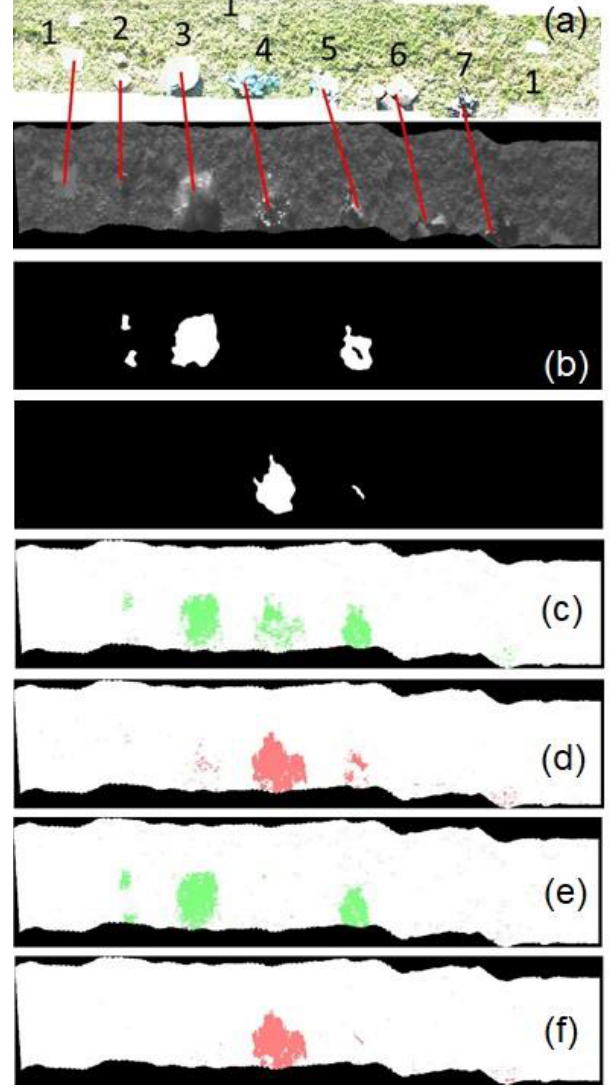
Figure 8. ( a ) Identification of materials. Panel above is a mosaic of visible-spectrum images, below the corresponding hyperspectral cube layer for wavelength 1010 nm; (1) white floor tiles; (2) LDPE wrapping bags; (3) LDPE wrapping sheet; (4) PET bottles (5) HDPE bottles; (6) wood; (7) glass bottles. Background is low grass. ( b ) Manually drawn masks for PE (above) and PET (below): Positive in white, negative in black. Classification results for classifiers trained on ( c ) Set 2, ( d ) Set 3, ( e ) Set 4, ( f ) Set 5: Positive in pink for PET, green for PE, negative in white. Optimized thresholds were used. It is apparent that the results obtained on the latter two sets are “cleaner” (more specific) and cover the areas better (more sensitive).